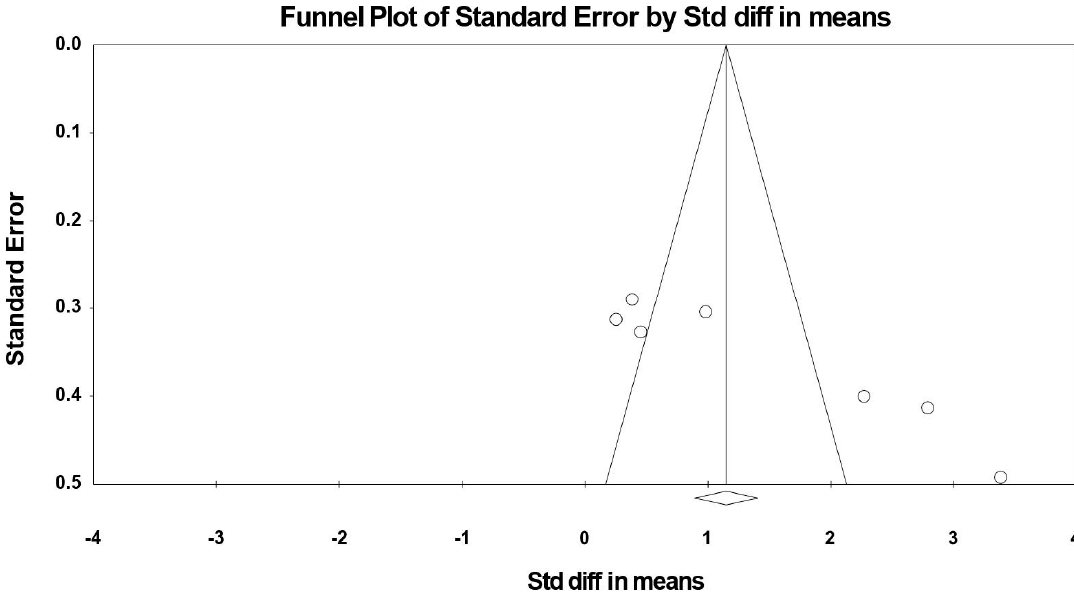
Figure 9. Funnel plot for SS-7s showing evidence of publication bias.